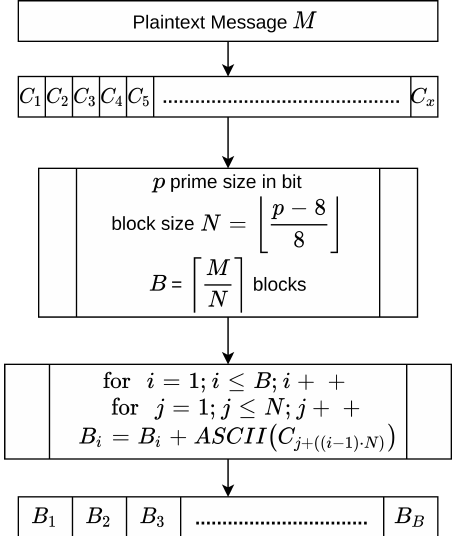
Figure 7. Converting plain text into a set of